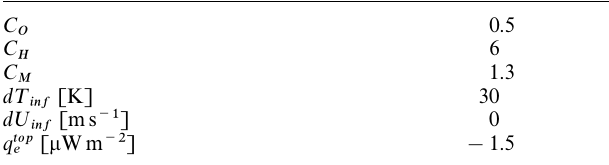
Table 2. List of adjustment parameters at 2300 UT for atomic oxygen O ( C (cid:79) ), atomic hydrogen H ( C (cid:72) ), atomic nitrogen and Fig. 4. a Spectral density of the flux of precipitating electrons used